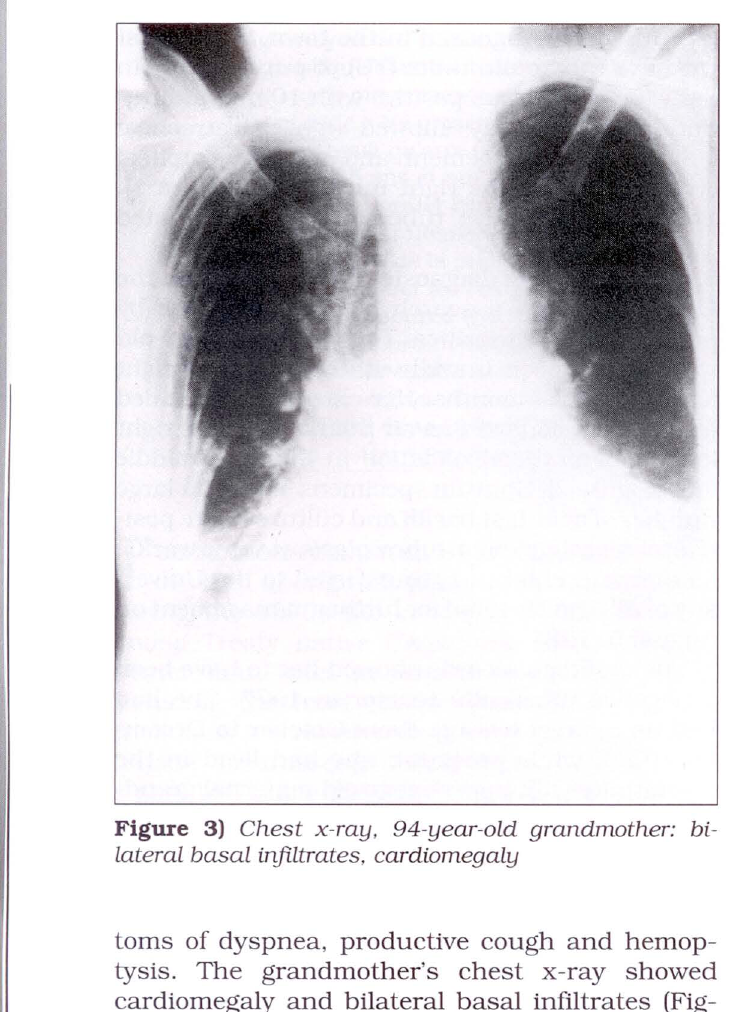
Figure 3) Chest x-ray, 94-year-old grandmother: bi lateral basal infiltrates,